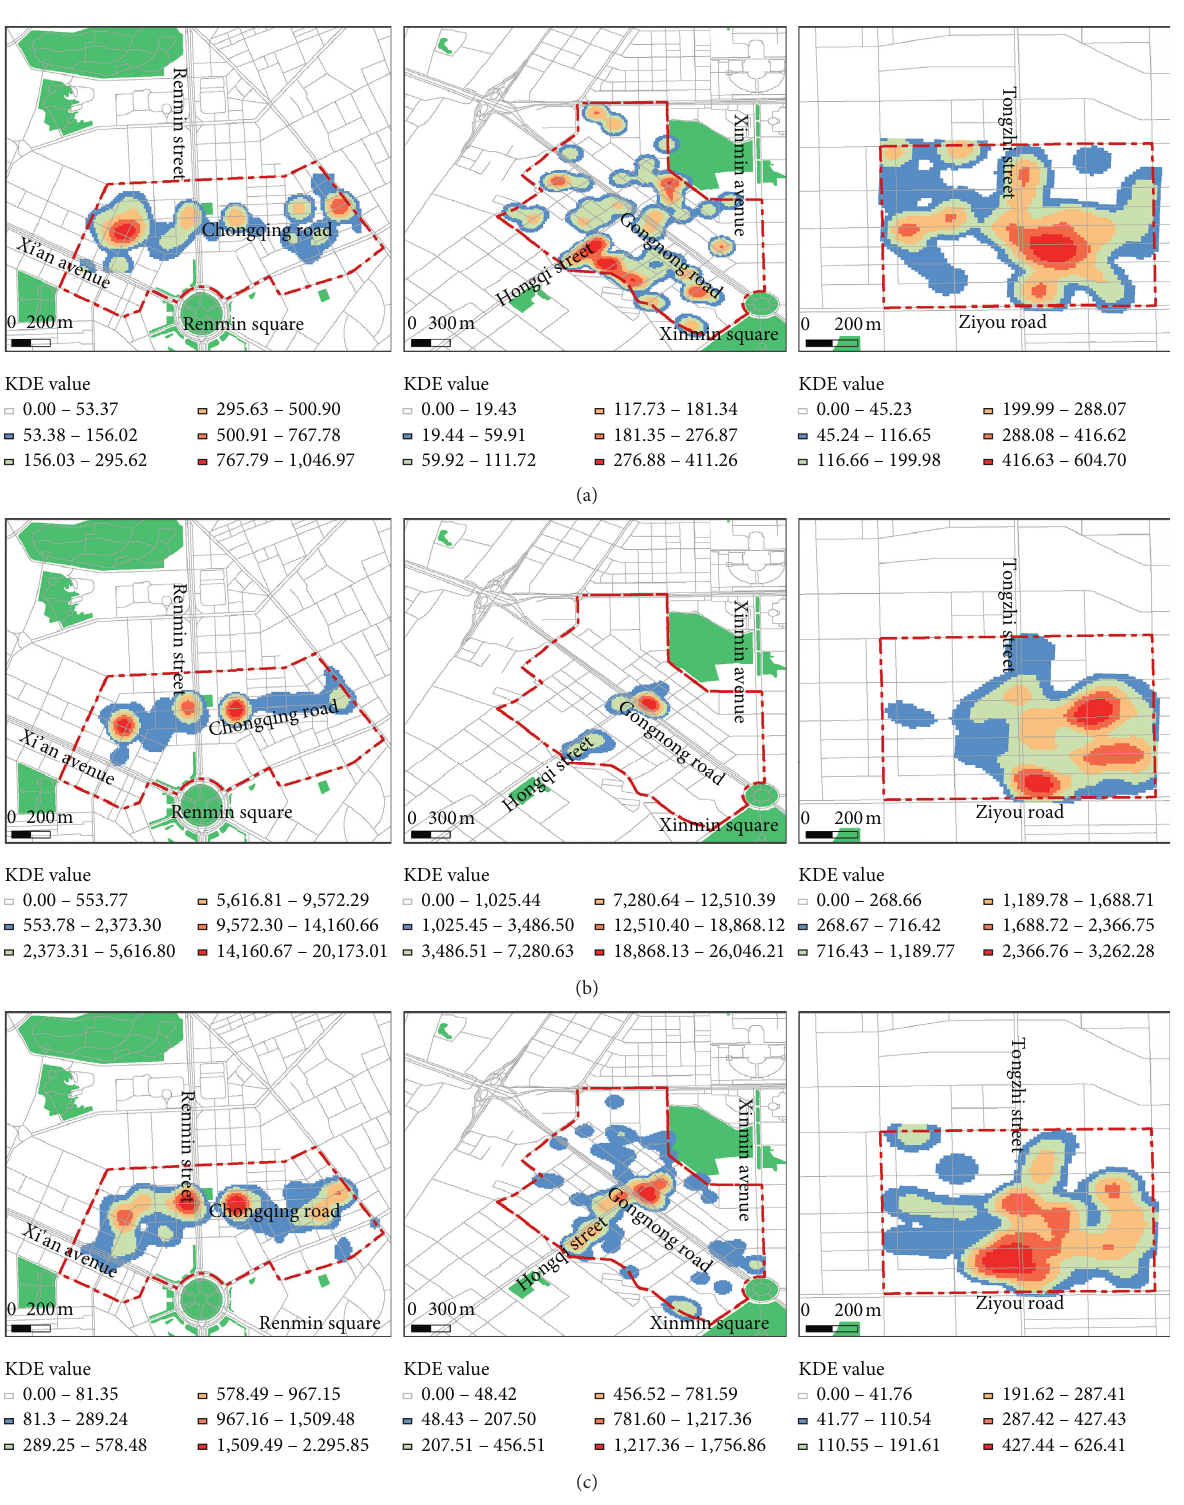
Figure 4: Spatial distribution of (a) IS, (b) TCS, and (c) CSS in the three commercial